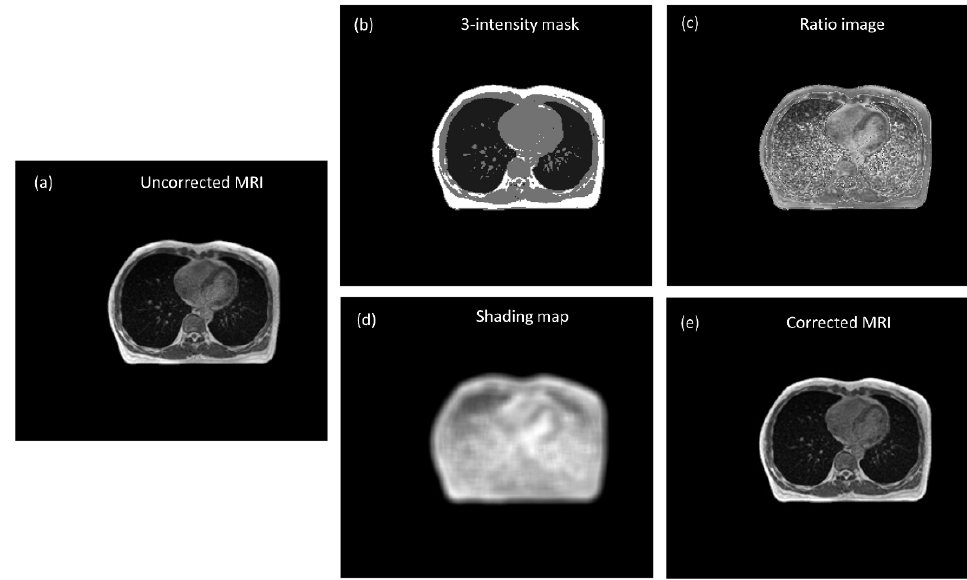
Figure 2. ( a ) Uncorrected MRI (WL/WW = 200/400), ( b ) three-intensity mask, ( c ) ratio image, ( d ) shading map, and ( e ) corrected MRI (WL/WW = 100/200).